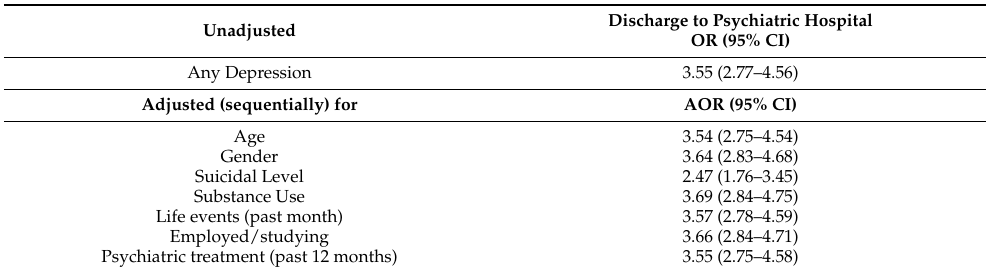
Table 3. Unadjusted and adjusted estimates for Any Depression predicting referral for psychi- atric admission.